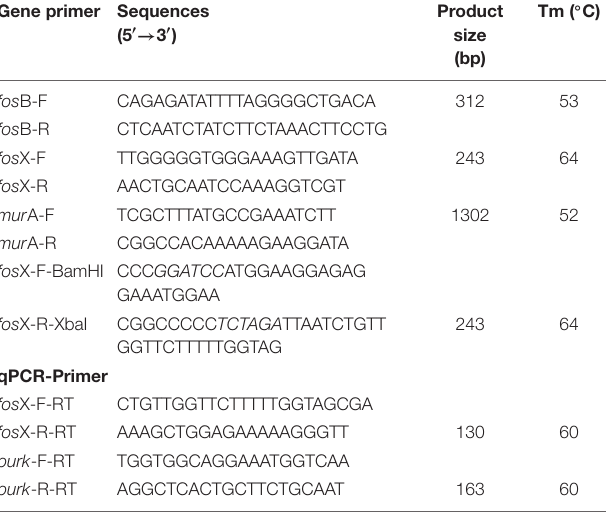
TABLE 1 | PCR primers of